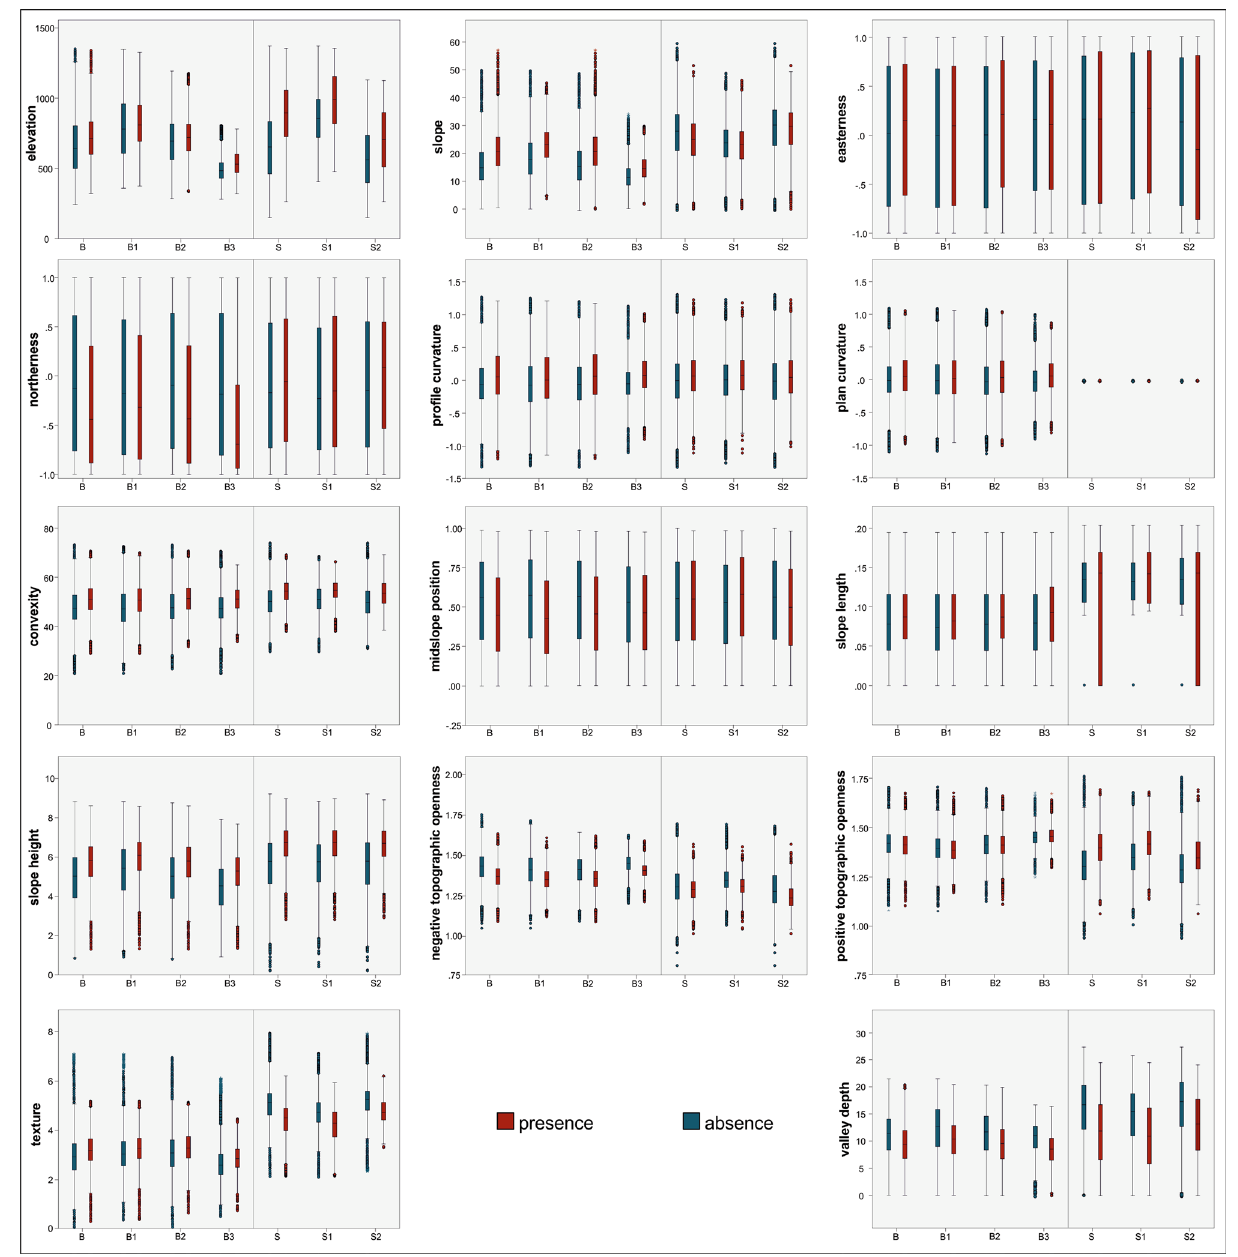
Figure 2. Distribution of terrain variables in the landslide presence and absence areas as represented by the box plot. Note that those variables with non-normal distributions have been subjected to normalization